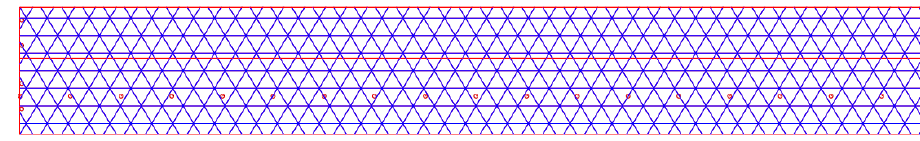
Figure 11. The composite beam model using the NMM.